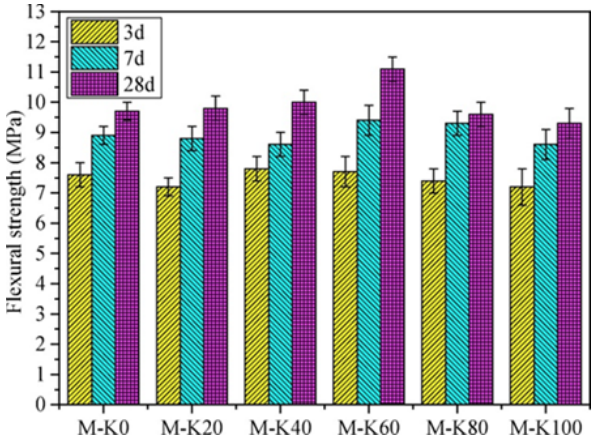
Figure 10: Flexural strength of mortars [40]